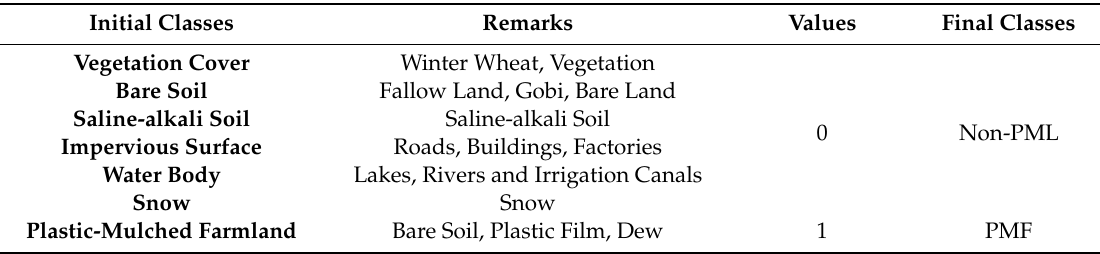
Table 5. The land cover classification